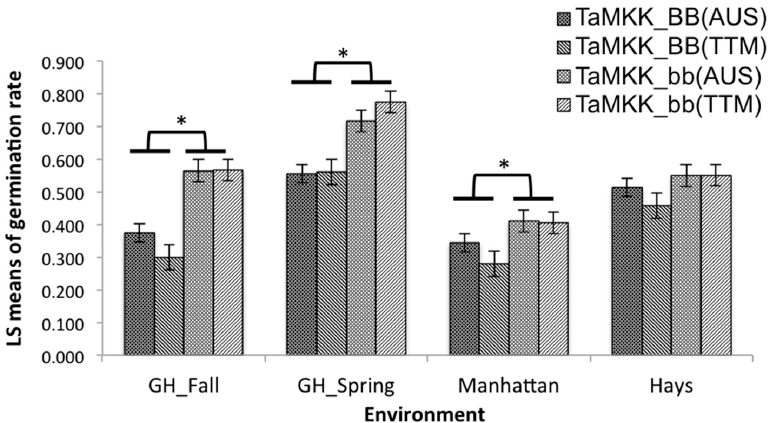
Figure 2. Effects of TaMKK3-A gene on germination rates evaluated in the 2015 fall and 2016 spring greenhouse experiments (GH_Fall and GH_Spring) and in the 2016 Manhattan and Hays, KS, field experiments . * Significant differences between least square means of germination rate between combined groups (indicated by black horizontal lines above the bars) at p < 0.05. Table 3. Combined genetic effects of TaPHS1 and TaMKK3-A genes from Tutoumai A and AUS1408 in both greenhouse and field experiments in Manhattan (MH) and Hays, KS.